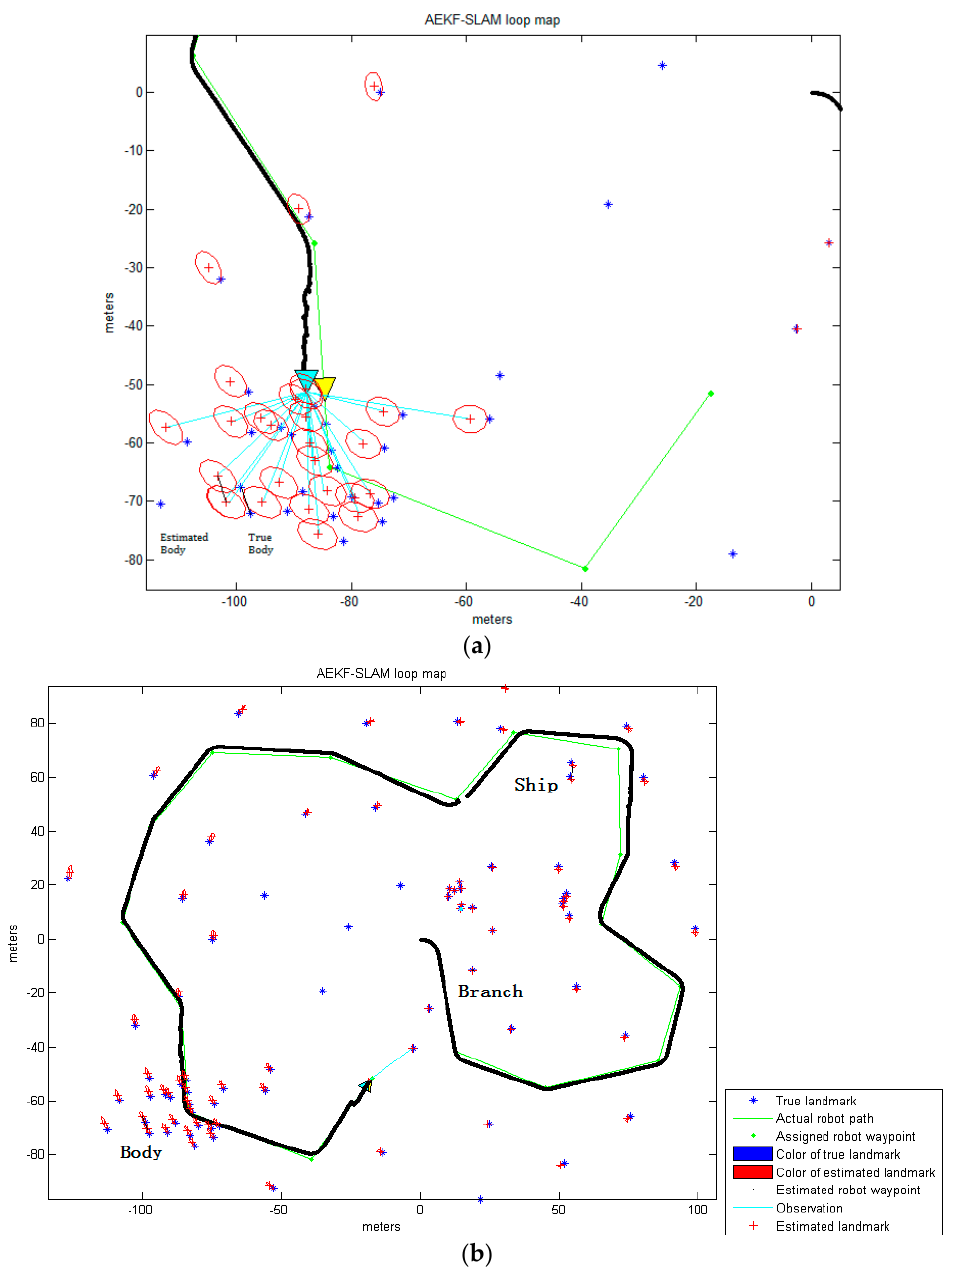
Figure 14. ( a ) The robot is observing the centroids of certain parts of the body before loop closure; ( b ) The final AEKF-SLAM loop map where the landmarks are detected by the maximum entropy TSM.